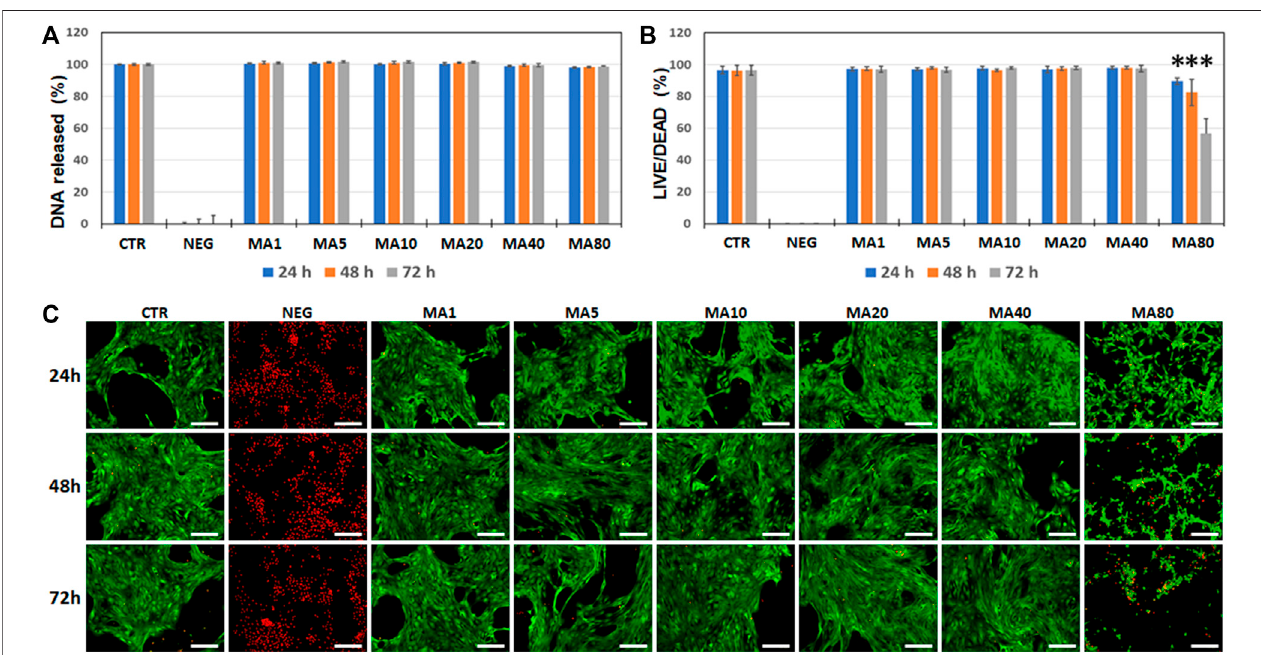
FIGURE 1 | Analysis of cell viability of immortalized human keratinocytes cultured in different types of media for 24, 48 and 72 h. Cells were cultured in control culture medium (CTR) and media containing increasing concentrations of maslinic acid (MA1, MA5, MA10, MA20, MA40, and MA80, corresponding to 1, 5, 10, 20, 40, and 80 μ g/ml of MA, respectively). As negative control (NEG), cells were incubated with 2% triton X-100. (A) : average values of cell viability as determined by quanti fi cation of DNA released to the medium after normalizing with respect to the CTR values. (B) : average values of cell viability as determined by LIVE/DEAD. In (A,B) , error bars correspond to standard deviations and asterisks show statistically-signi fi cant differences with CTR. (C) : fl uorescence microscopy images of cells stained with the LIVE/DEAD system. Live cells are labeled in green and dead cells are labeled in red. Scale bars: 200 µm.